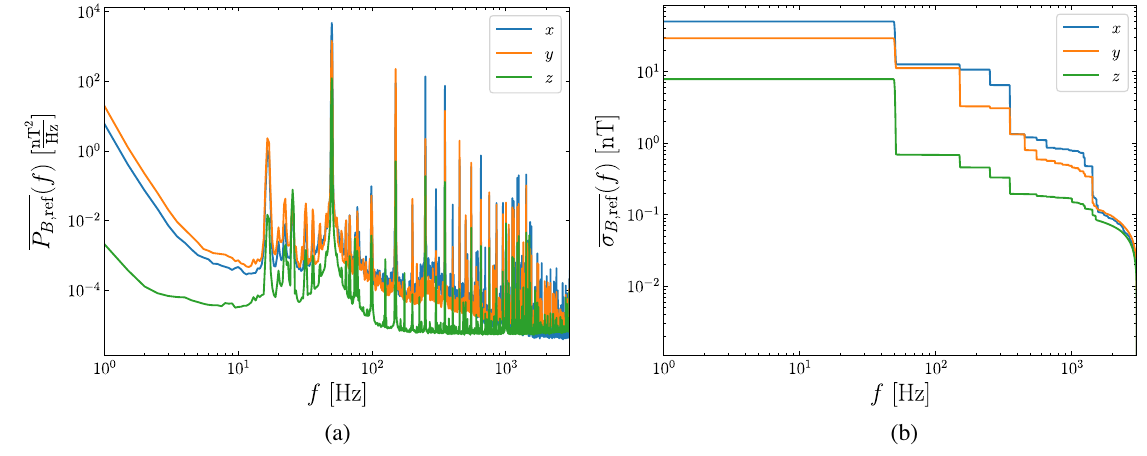
f Þ vs frequency f and (b) standard deviation σ ref ð